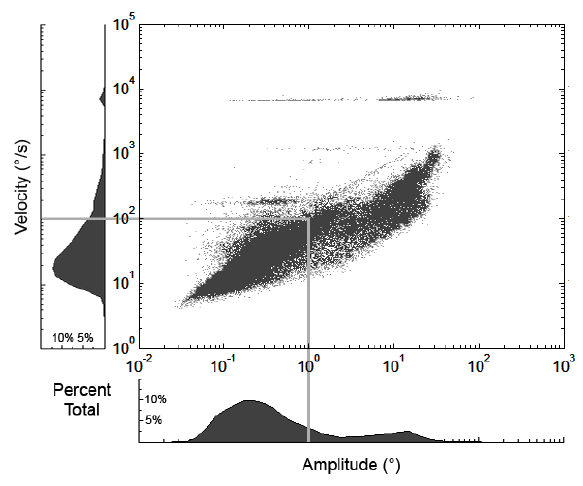
Figure 3. A log-log main sequence plot, flanked by frequency polygons to impart density information. Light grey lines indicate microsaccade thresholds.